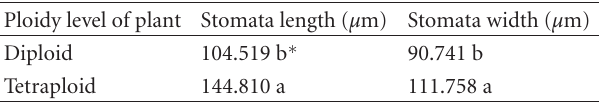
Table 5: Comparison of stomata size between diploid and tetraploid